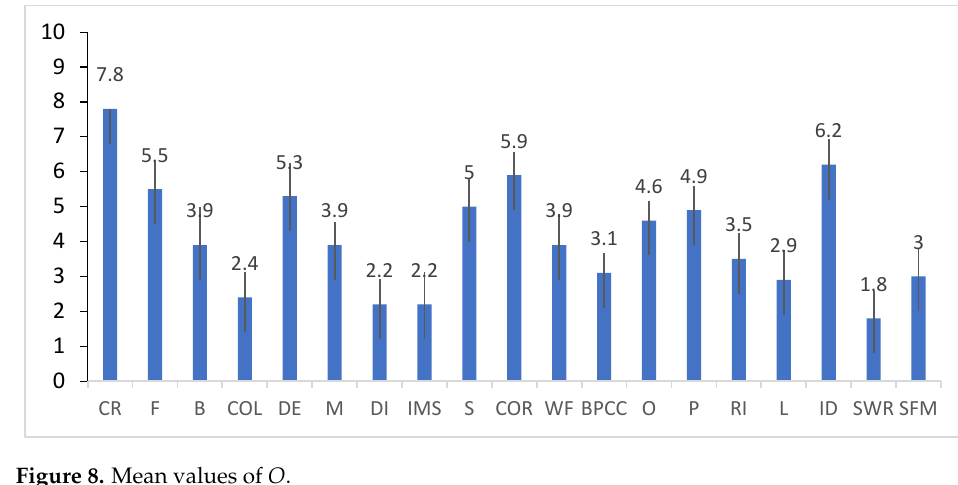
Figure 8. Mean values of 𝑂 .